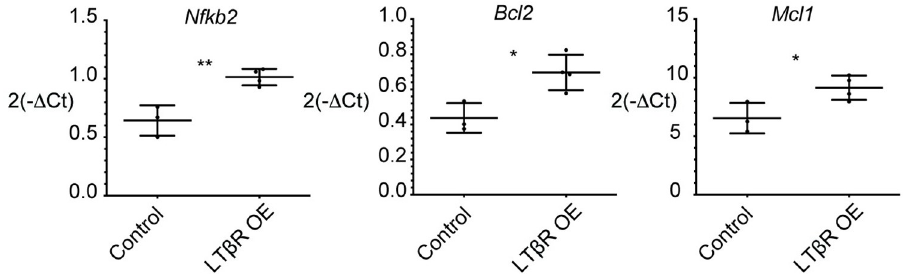
Fig 6. LT β R OE PCs have greater transcription of Nfkb2 , Bcl2 , and Mcl1 . B cell specific LT β R OE or control chimeras were generated as in Fig 4 . Dump - CD138 + B220 - TACI + CD98 + CD45.2 + Thy1.1 + or Thy1.1 - PCs were sorted from spleens. qPCR analysis was conducted to determine the transcription levels of Nfkb2 , Bcl2 , and Mcl1 . Control samples consist of Thy1.1 + or Thy1.1 - PCs from Empty-MSCV-Thy1.1 chimeras and Thy1.1 - PCs from loxp-EGFP- loxp-Ltbr-MSCV-Thy1.1 chimeras. In some instances, cells from multiple mice were combined into one sample to obtain sufficient cells for analysis. Pooled data from two independent experiments are shown. � p < 0.05, �� p < 0.01.